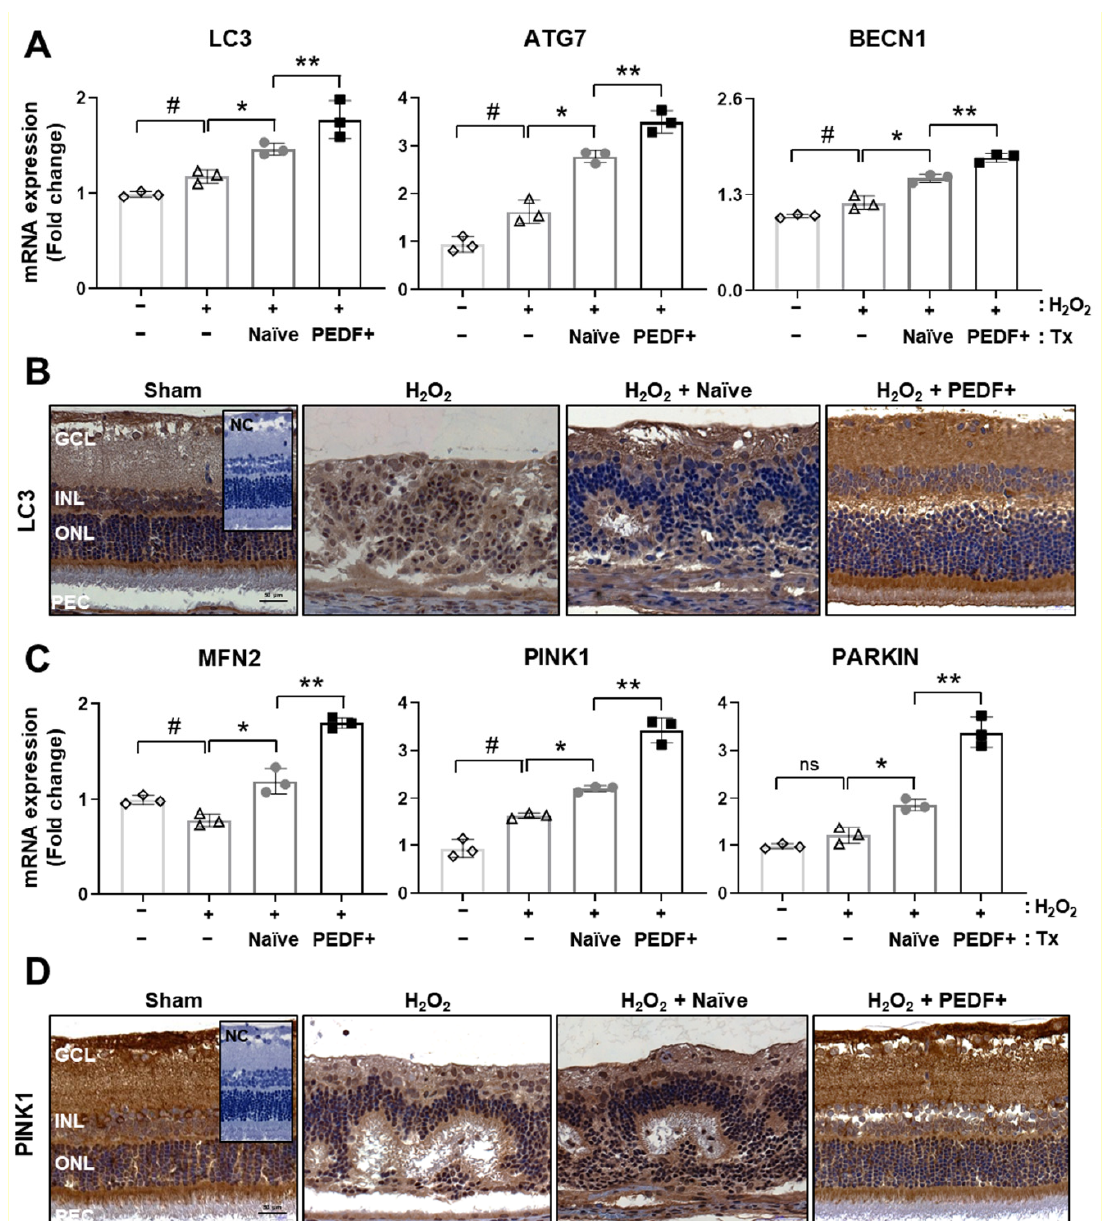
Figure 5. The administration of PD-MSCs PEDF induces mitophagy in H 2 O 2 -injured rat retinas. ( A ) The mRNA expression of autophagy markers (e.g., LC3, ATG7, and BECN1) was determined by qRT-PCR after naïve PD-MSC (H 2 O 2 + Naïve) and PD-MSC PEDF (H 2 O 2 + PEDF+) transplantation. ( B ) LC3 expression in the rat retinas of each group was determined by IHC ( n = 6). Scale bar = 50 μ m. ( C ) qRT-PCR analysis of mitophagy markers (e.g., MFN2, PINK1, and PARKIN) in the rat retina. ( D ) IHC analysis of PINK1 expression in the rat retina in each group ( n = 6). Scale bar = 50 μ m. The data represent the mean ± SD and were analyzed by one-way ANOVA. # p < 0.05 vs. Sham ( − ), * p < 0.05 vs. H 2 O 2 , ** p < 0.05 vs. Naïve.